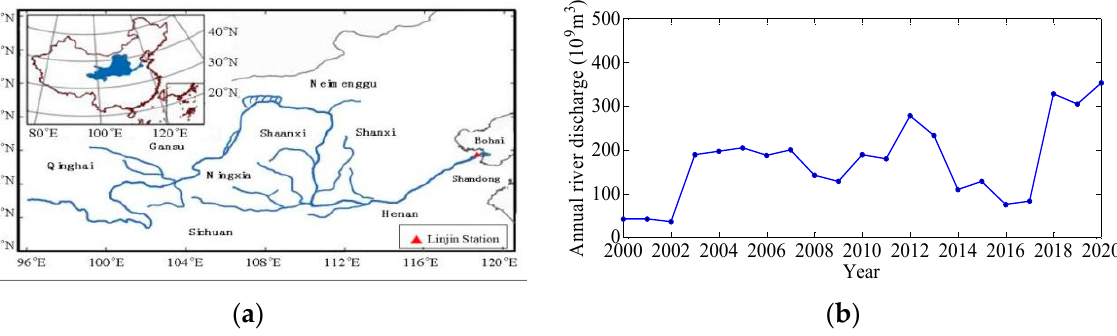
Figure 1. The locations of the Yellow River and Lijin station ( a ) and annual runoff of the Yellow River from 1952 to 2017 ( b ).